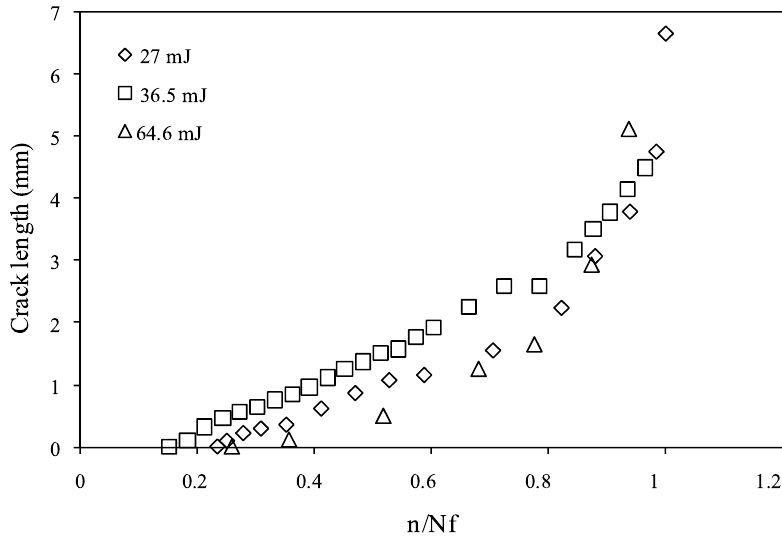
Fig. 7. Crack length as a function of normalised impact fatigue